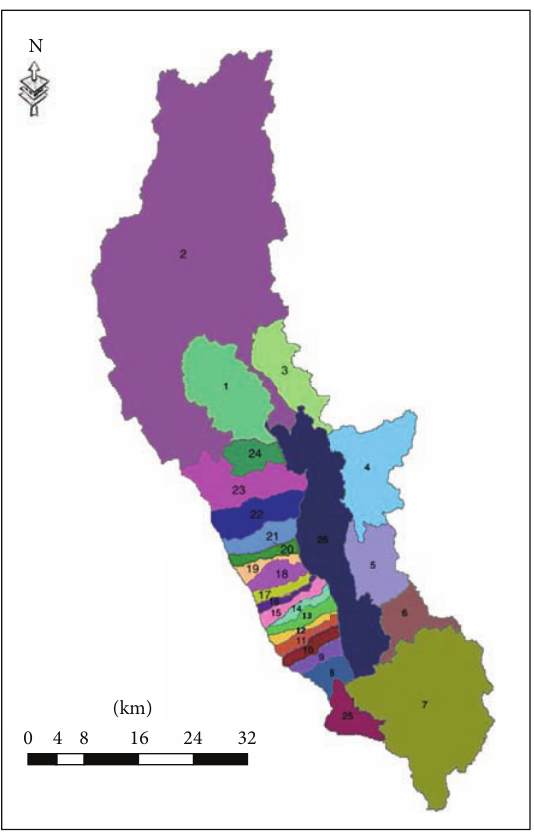
Figure 2: Rivers into the Erhai